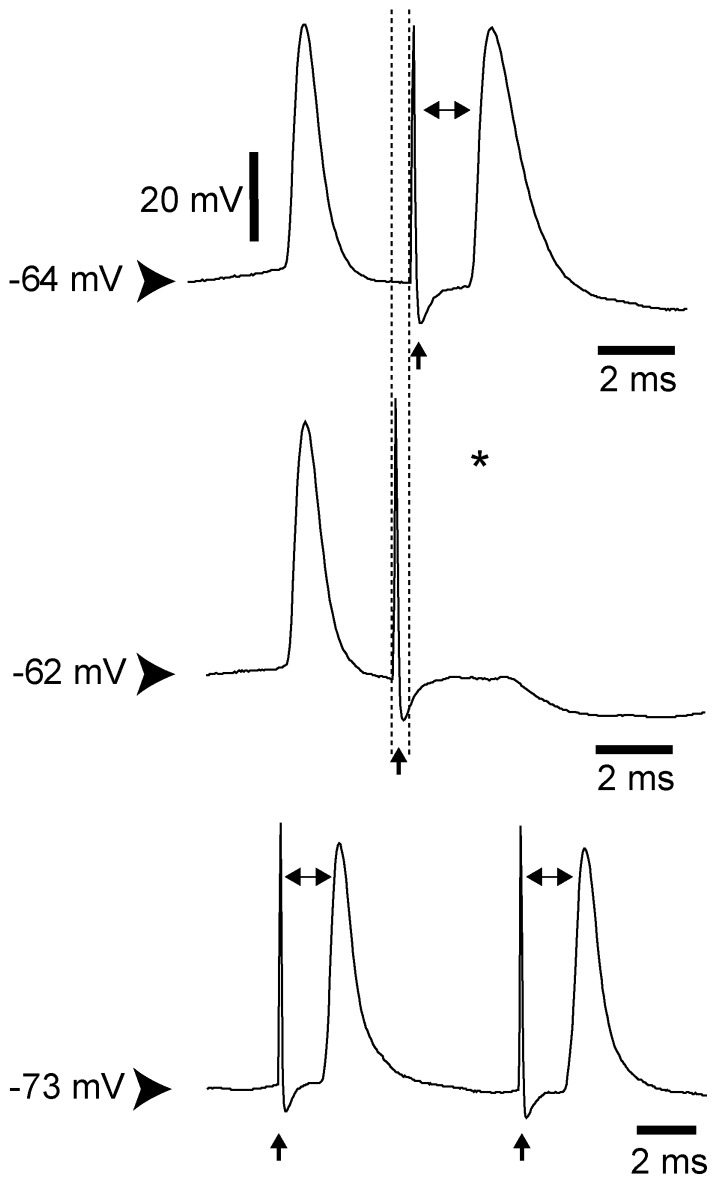
Electrophysiological identifications of pyramidal neurons.Cortico-STN and cortico-striatal neurons were identified by their antidromic activation following electrical stimulation of the ipsilateral STN and contralateral striatum, respectively. Intracellular characterization of the antidromic spike evoked in a pyramidal cell by ipsilateral STN stimulation: The antidromic latency (1.5 ms), which was measured as indicated by the double-headed arrows, was not affected by DC-induced hyperpolarization (from −64 to −73 mV; i
DC −0.5 nA). The top trace shows no collision between orthodromic and antidromic spikes when the STN stimulation is applied 3.3 ms after a spontaneous orthodromic action potential. The middle trace shows a collision of an antidromic spike (asterisk) with a spontaneous orthodromic action potential occurring at an appropriate time interval. In each trace, the values of the membrane potential are indicated on the left.